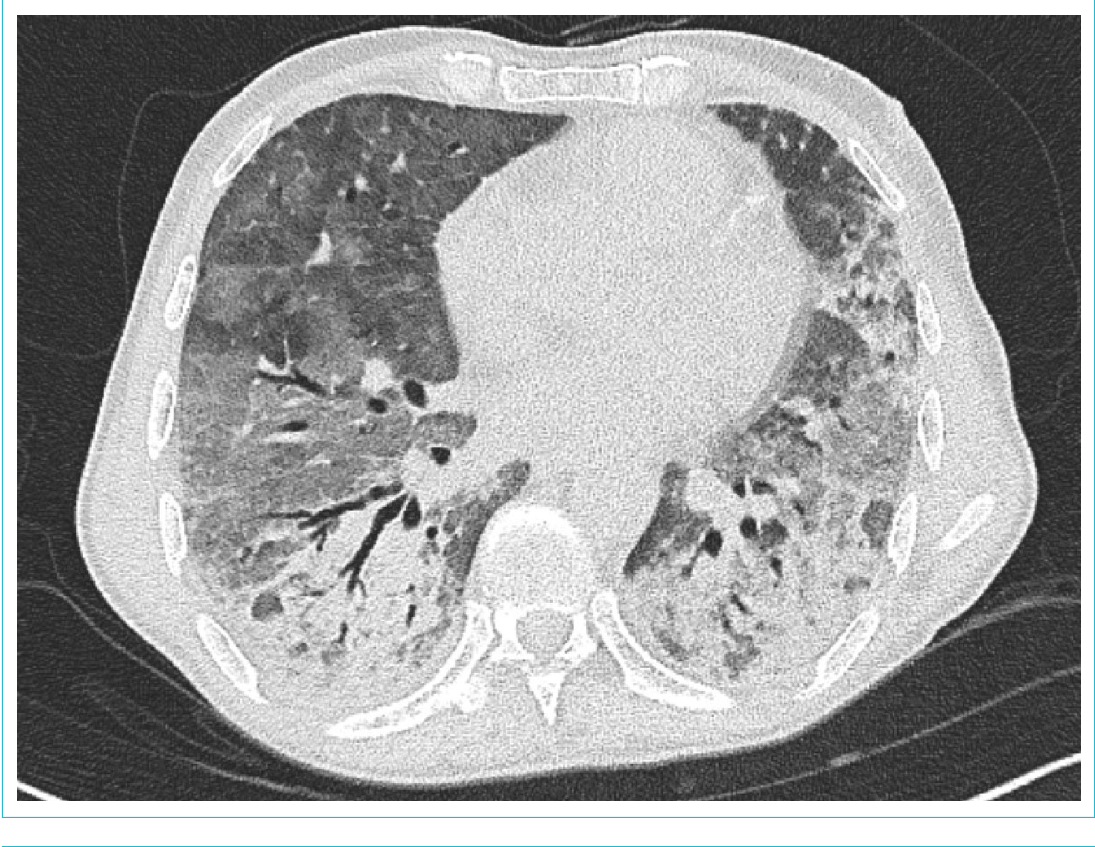
Figure 4: Chest computed tomography on day 7 showing diffuse bilateral infiltrates and ground-glass opacities.